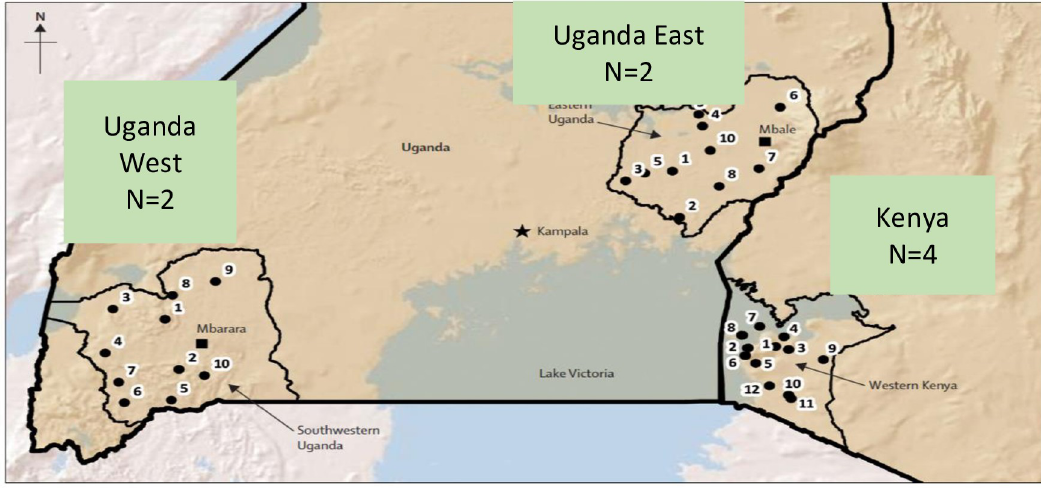
Fig 1. SEARCH study